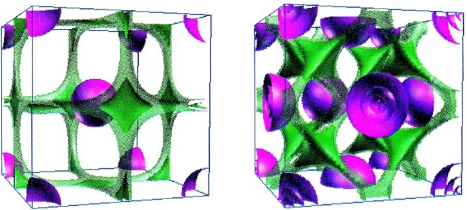
The localization domains for Li (left) and Sc (right) crystals based on the electronic localization function ELF (59) [55].